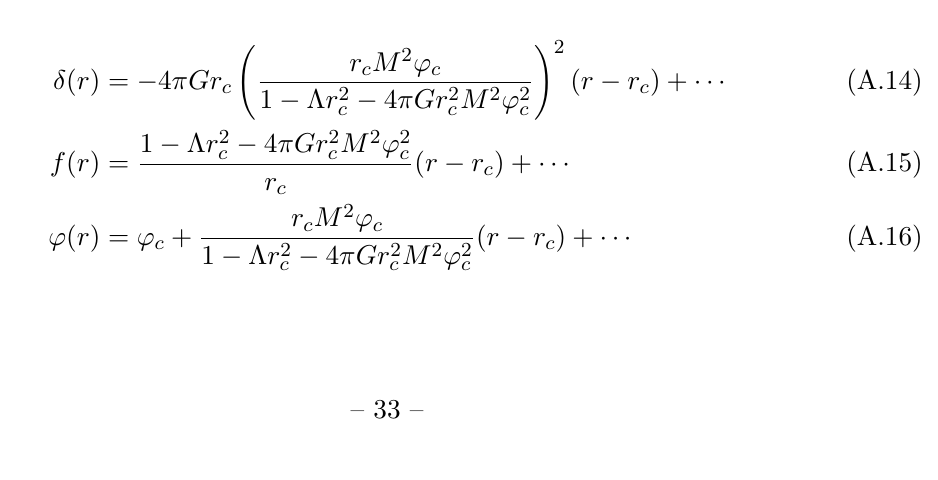
Figure 25 . Solutions f, ϕ, δ of Eulidean BH when r H is 0 . 5 ϕ H is chosen so that J ϕ = 3 /